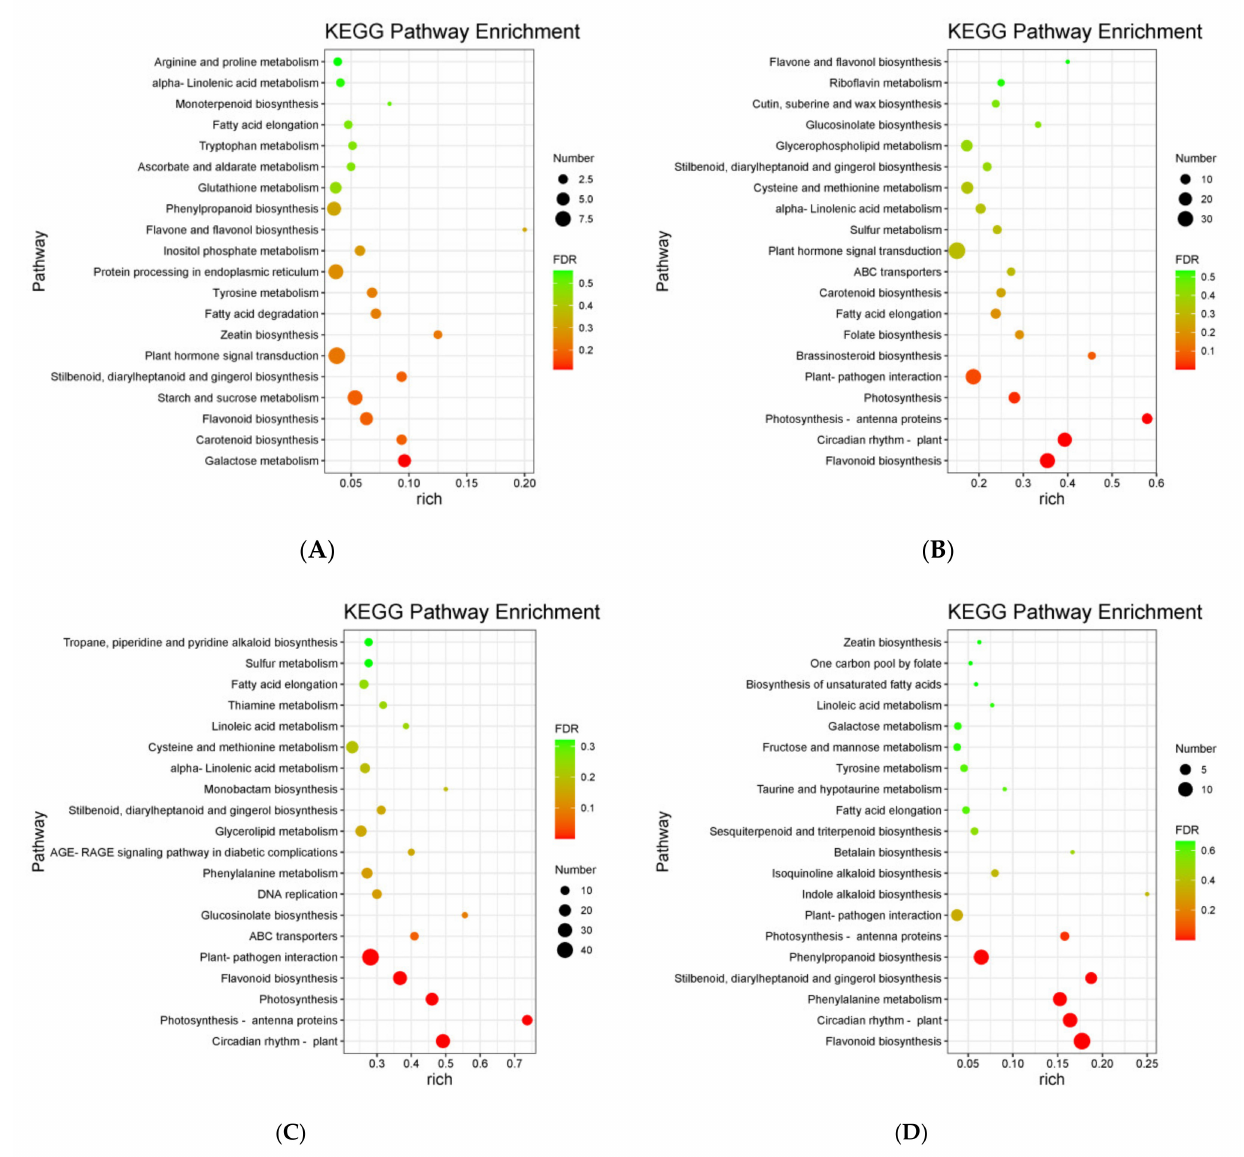
Figure 3. The top 20 enriched KEGG pathways of DEGs. ( A ) CK vs. T1 at 90 DAFB; ( B ) CK vs. T2 at 90 DAFB; ( C ) CK vs. T1 at 110 DAFB; ( D ) CK vs. T2 at 110 DAFB. The circle size represents the number of DEGs detected in the KEGG pathway. The rich factor is the ratio of DEGs to the total background gene number in each